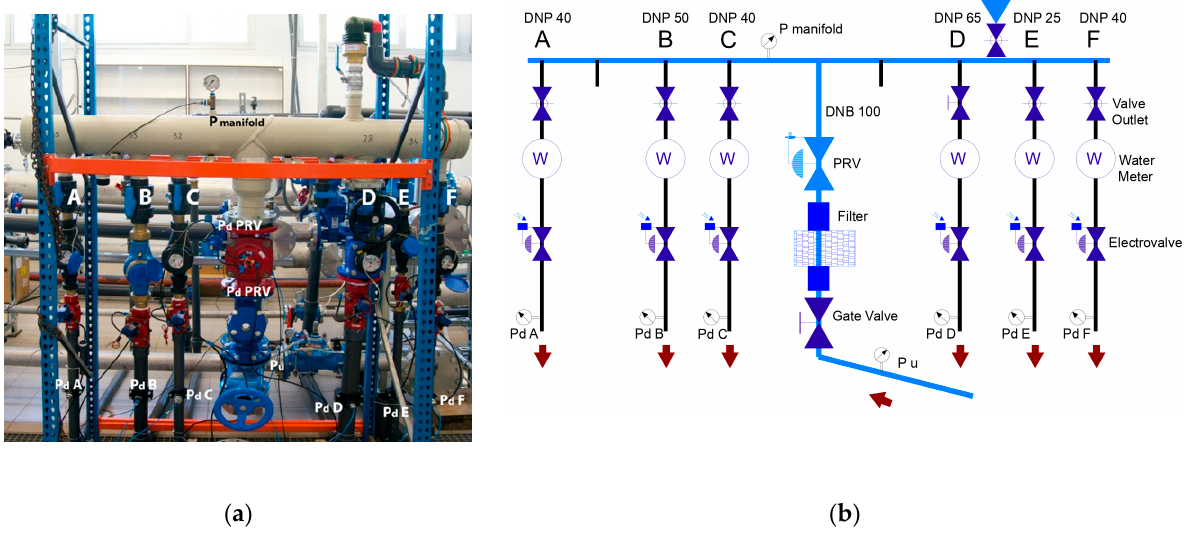
Figure 6. ( a ) Head loss test for multioutlet hydrant number 9 (V2/Type 3-6/DNB100-QNB 73.5-DNP 25 x1 40 x3 50 x1 65 x1/PN10). Specific outlet diameters A: DNP 40; B: DNP 50; C: DNP 40; D: DNP 65; E: DNP 25; F: DNP 40; ( b ) Head loss test scheme for hy-drant number 9.